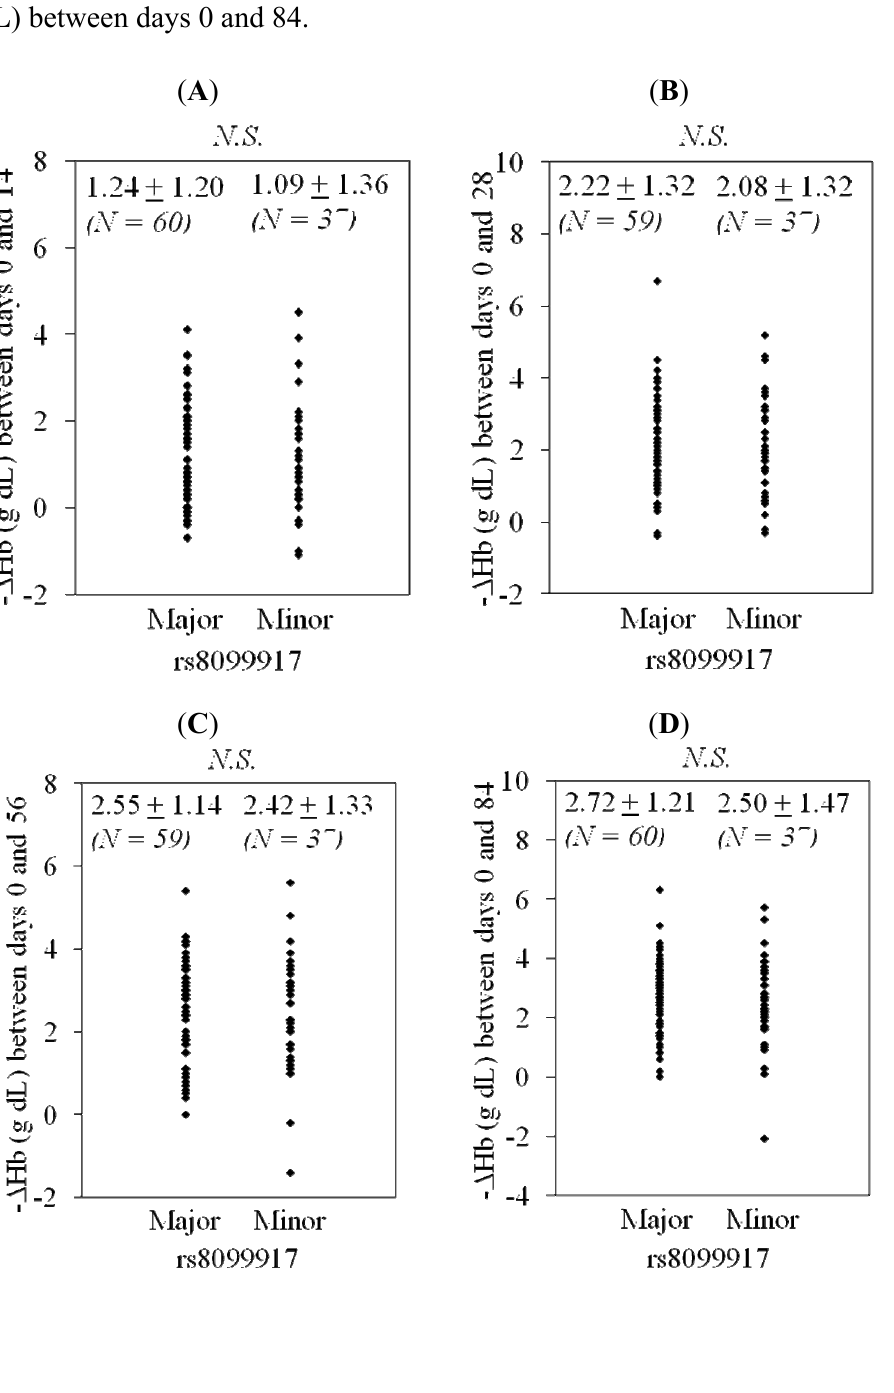
Figure 1. Ribavirin-induced reduction of hemoglobin according to IL28B and